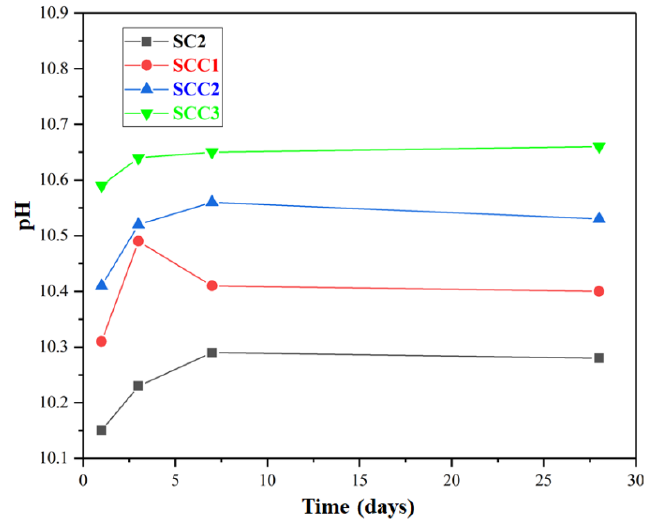
Figure 5. pH value of liquid for cement.